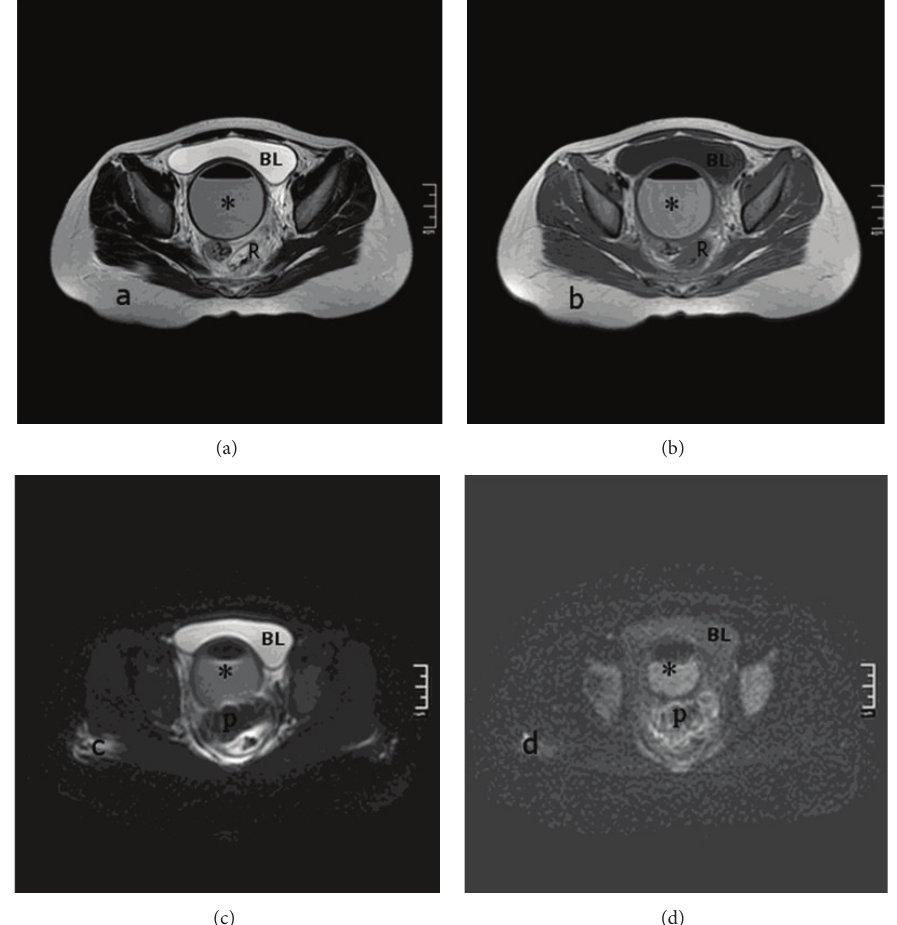
Figure 2: (a) Axial T2-weighted FSE image. Material with air-fluid level shows lower signal-intensity than bladder (BL). (b) Axial T1-weighted FSE image. Material with air-fluid level shows higher signal-intensity than bladder (BL), ((c), (d)) apparent diffusion coefficient (ADC), and diffusion-weighted image (DWI). Restricted diffusion indicates purulent collection in the rectovaginal space, pus (P), and vagina ( ∗ ) rectum was compressed by the rectovaginal space leakage posterolaterally, rectum (R).